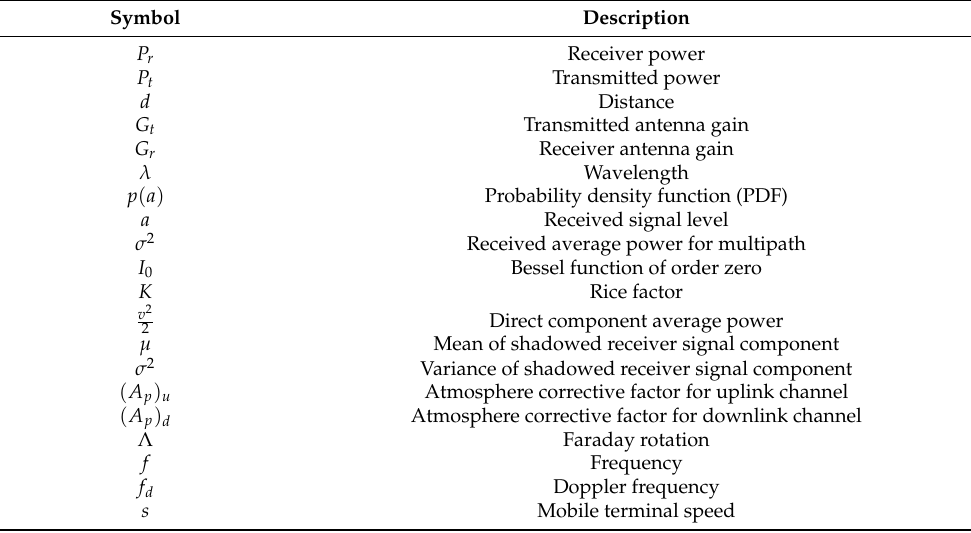
Table 3. Symbols used in Propagation Characteristics and Phenomena of LMS Communication